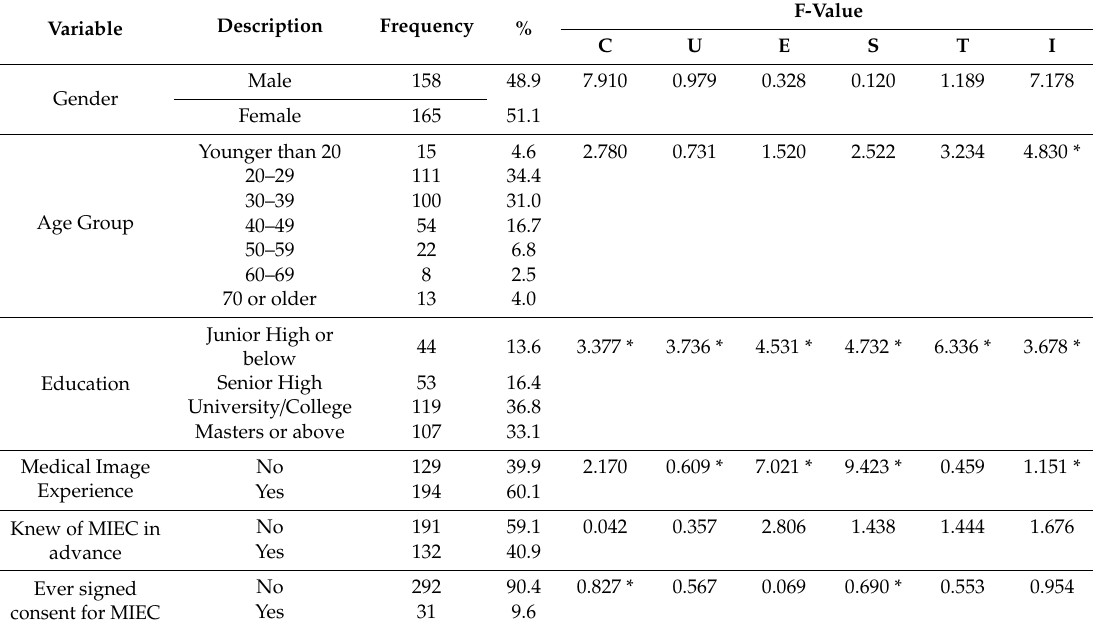
Table 1. Demographics for the sample